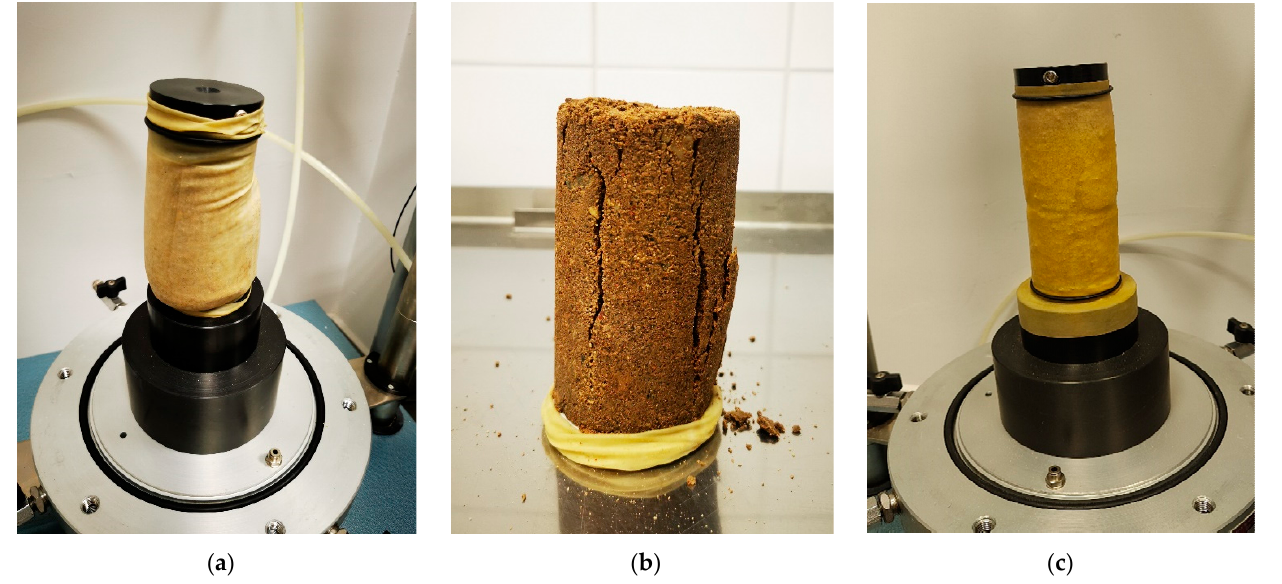
Figure 7. Typical failure modes of samples in the M r tests: ( a ) grSa compacted via SP method damaged during the M r test (sequence 1); ( b ) grSa + 1.5C compacted via MP method, cured for 7 days, after cyclic test and quick shearing; ( c ) grSa + 1.5C + 0.3%F 18 mm compacted via SP method, cured for 7 days, after cyclic test and quick